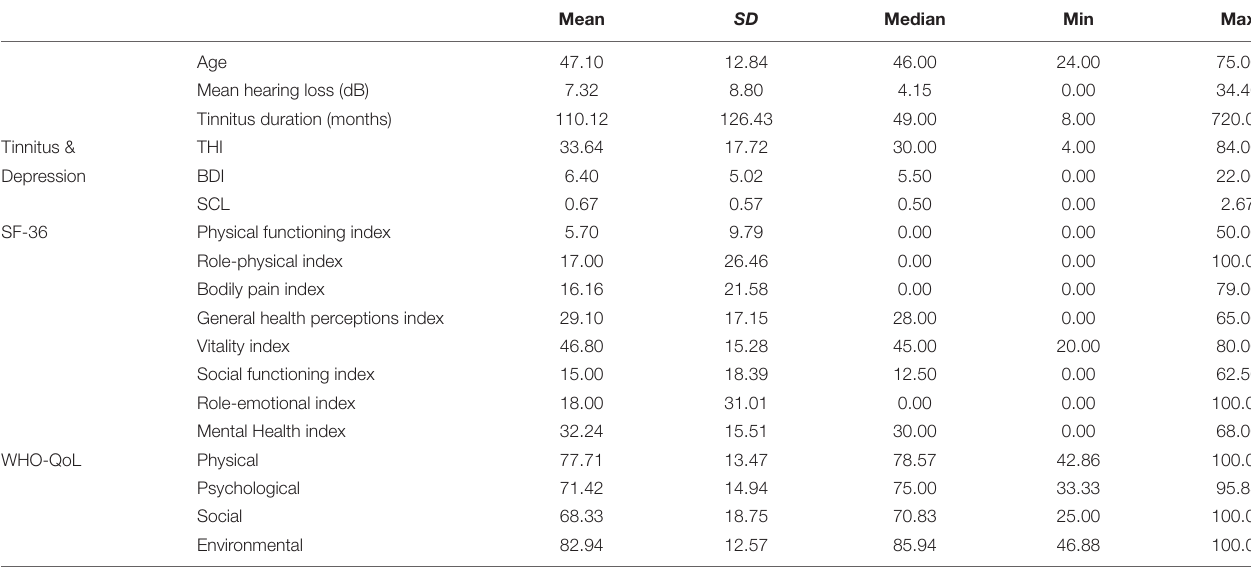
TABLE 1 | Demographic, health, and tinnitus characteristics of study